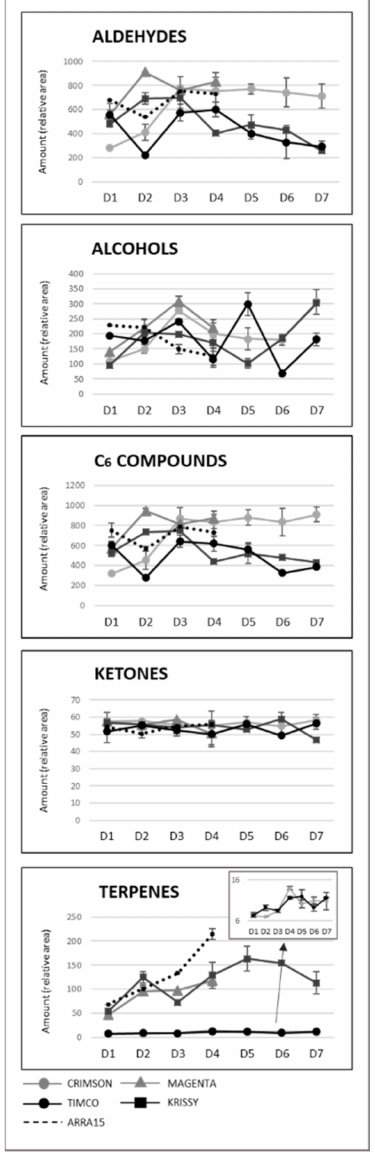
Figure 4. Evolution of the main chemical groups of volatile compounds during ripening and storage. Sampling along harvest: D1 , veraison; D2 , 12 DAV (days after veraison); D3 , 26 DAV; D4 , 37 DAV. Sampling along storage: D5 , 54 DOS (days of storage); D6 , 75 DOS; D7 , 108